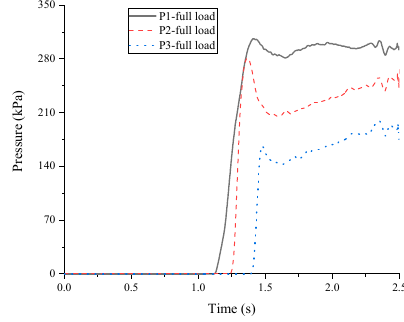
Figure 24. Pressure at P1, P2 and P3 at half load.